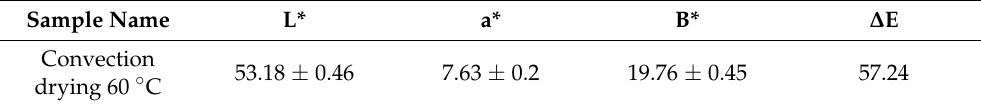
Table 8. Color characteristics of apple pomace given in CIE L* a* b* units.